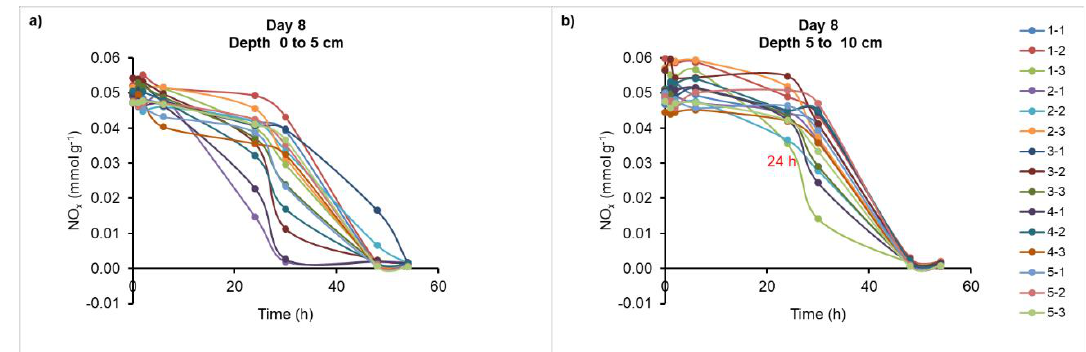
Figure 8. Example plots of nitrate/nitrite (NO x ) disappearance over 54 h of anaerobic incubation for denitrification enzyme activity (DEA) studies in manure from ( a ) 0–5 cm depth and ( b ) 5–10 cm depth. These data were used to calculate DEA rates.